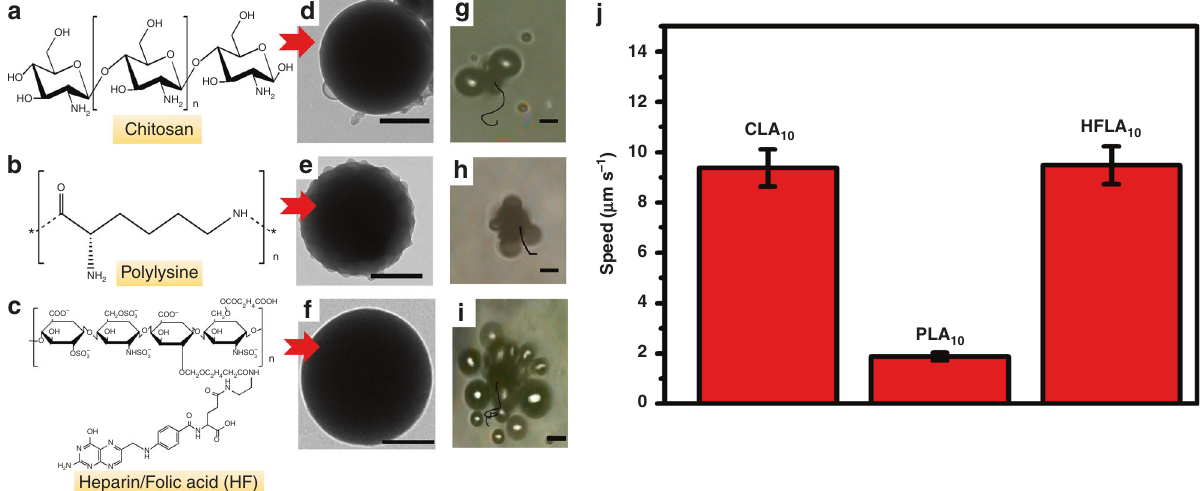
Fig. 7 Characterizations of nanomotors with other components. Nanomotor with their counterpart chemical structure of a chitosan, b polylysine, c heparin/ folic acid; TEM images of d CLA 10 nanomotor, e PLA 10 nanomotor, and f HFLA 10 nanomotor (Scale bar: 200 nm); Time-lapse images (Supplementary Movie 7) displaying the tracking trajectories in 10 s (10% H 2 O 2 ) of g CLA 10 nanomotor, h PLA 10 nanomotor, and i HFLA 10 nanomotor (Scale bar: 5 μ m); j The movement speed of the different nanomotors. Experimental data are mean + / − s.d. of samples in a representative experiment ( n =